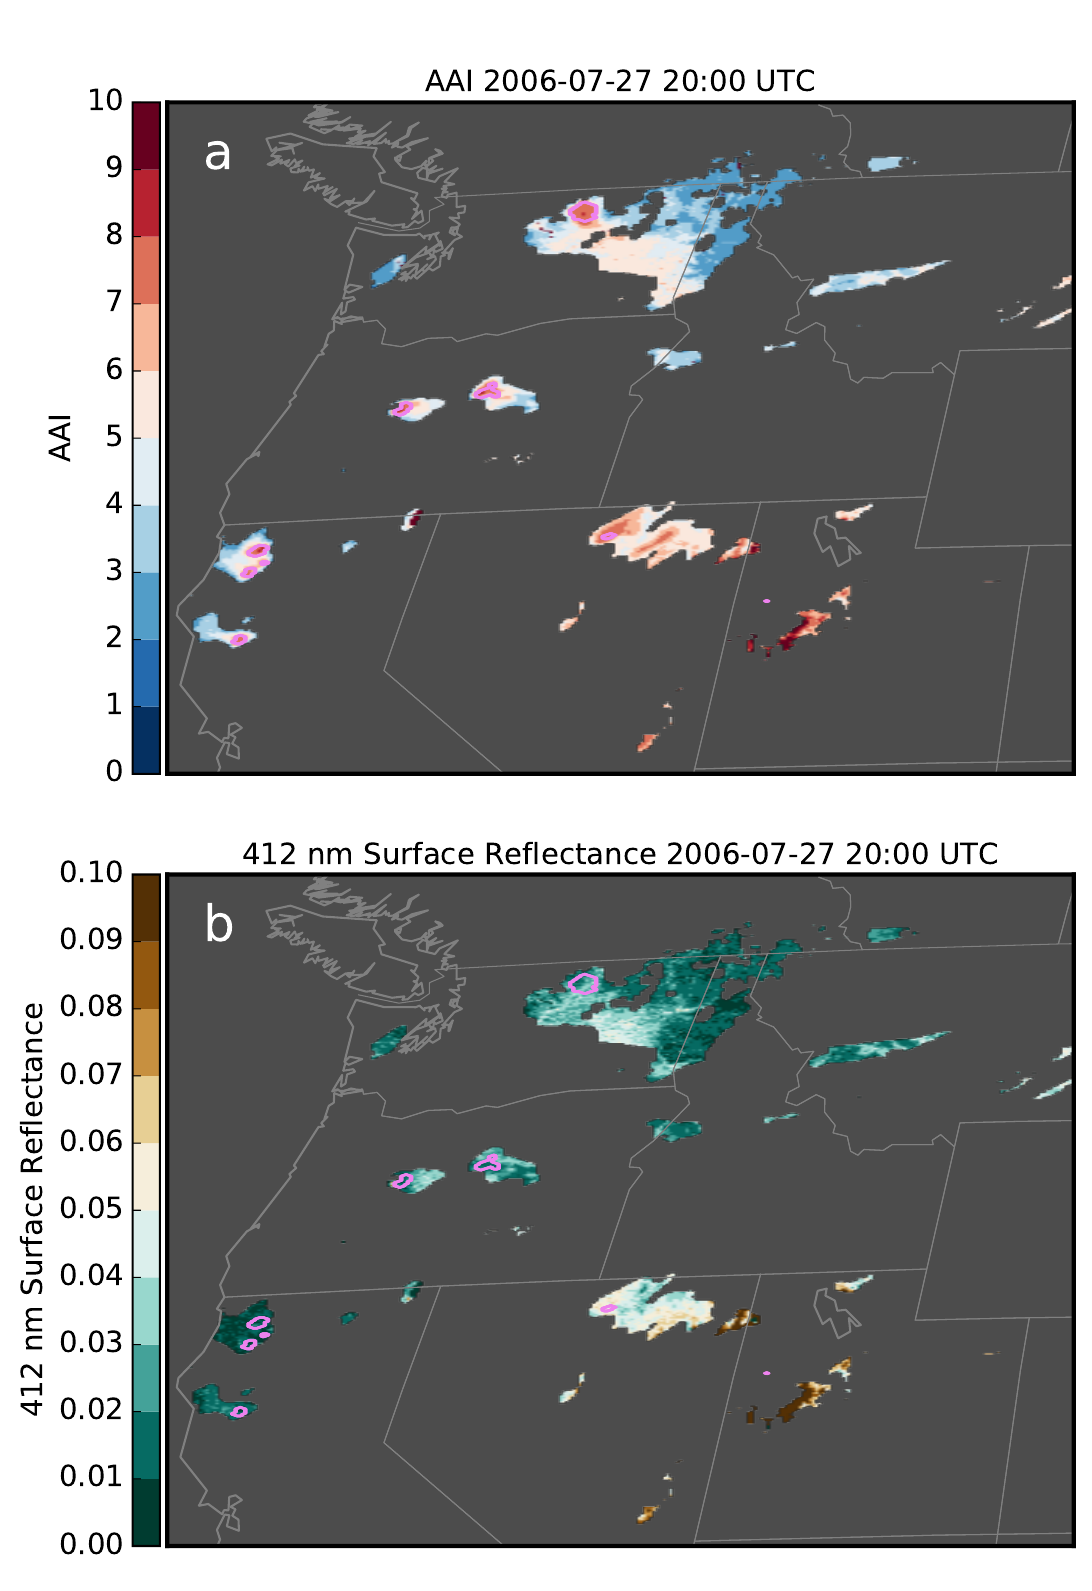
Figure 13. ( a ) Simulated Aerosol Absorbing Index (AAI), ( b ) TEMPO 412 nm surface reflectance used for AAI and DSDI calculations for 27 July 2006 at 21 UTC in the G5NR simulation. The purple contours represent the areas that were detected as smoke by the VIIRS aerosol detection